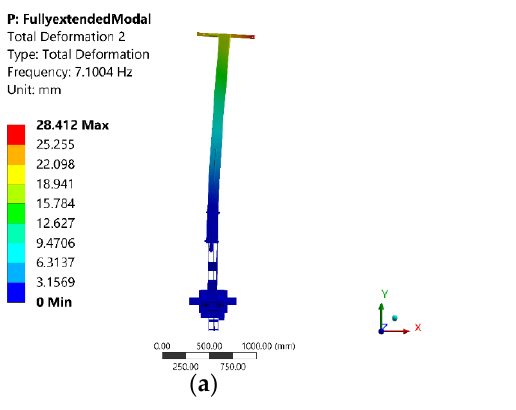
Figure 7. The 2nd mode shape of vibration for the Fully-extended configuration, arm is fixed at the base ( a ) top view & ( b ) front view.